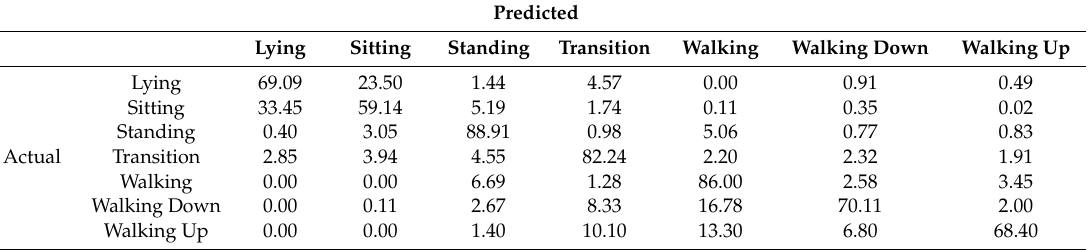
Table A8. Confusion matrix for the CNN-LSTM (in percentages, averaged over 10 runs). Predicted Lying Sitting Standing Transition Walking Walking Down Walking Up Lying Actual